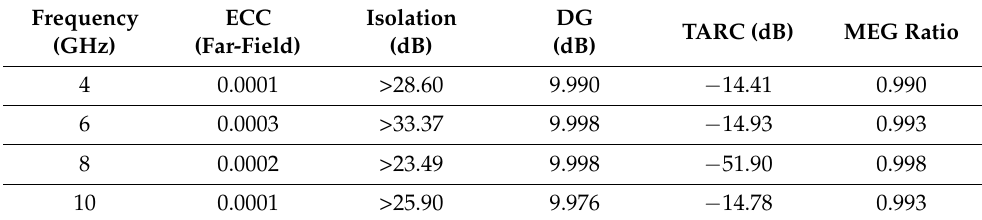
Table 1. UWB MIMO antenna performance at different frequencies.